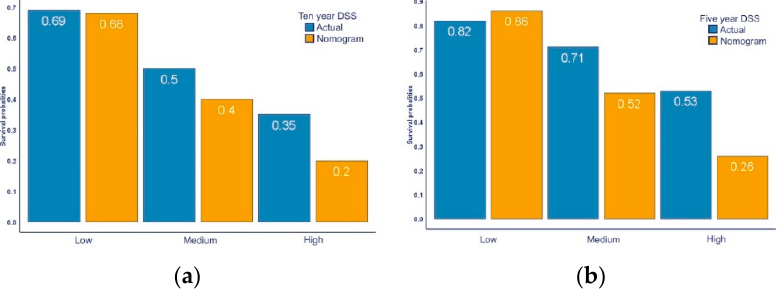
Figure 2. Actual disease specific survival vs. nomogram disease specific survival: ( a ) Five-year DSS categorised in low-, medium- and high-risk group, scenario 1; ( b ) Ten-year DSS categorised in low-, medium- and high-risk group, scenario